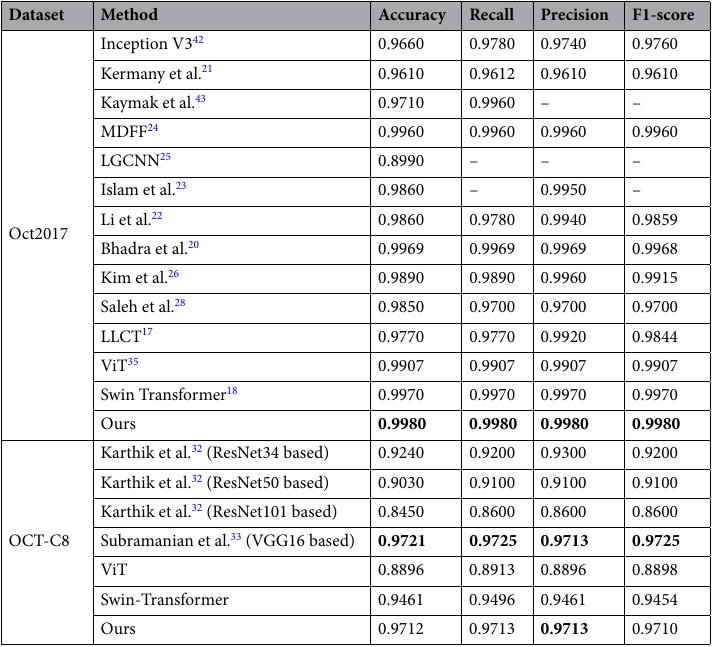
Table 2. Performance of several deep learning networks for classification on OCT2017 and OCT-C8. Significant values are in [bold].